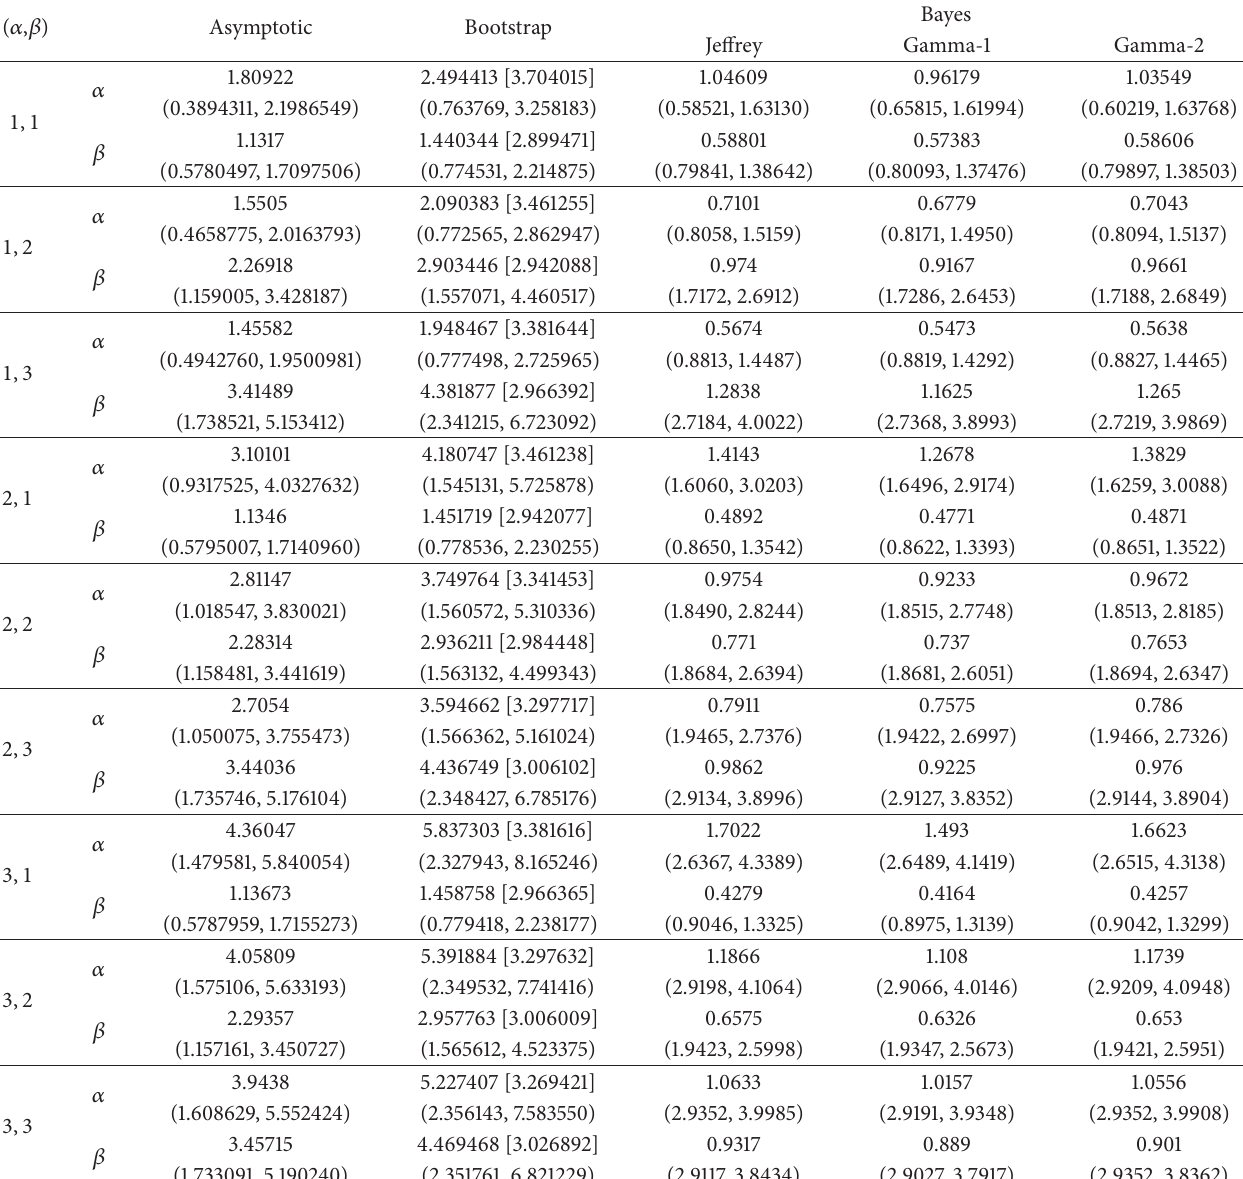
Table 8: Average 95% confidence/HPD intervals (in brackets) and bootstrap method along with their width and shape (in square brackets) for bootstrap method for complete sample 𝑛 = 20 , 𝑟 = 12 with varying